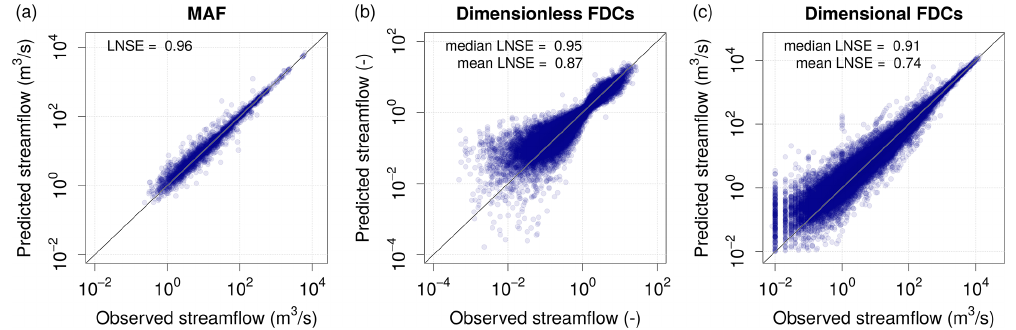
Figure 4. Results of the top-kriging interpolation in cross-validation (LOOCV). For (a) MAF, (b) dimensionless FCDs, and (c) dimensional FDCs, empirical ( x axes) vs. predicted ( y axes) values are reported together with the overall Nash–Sutcliffe efficiency for log-transformed (LNSE) streamflows.